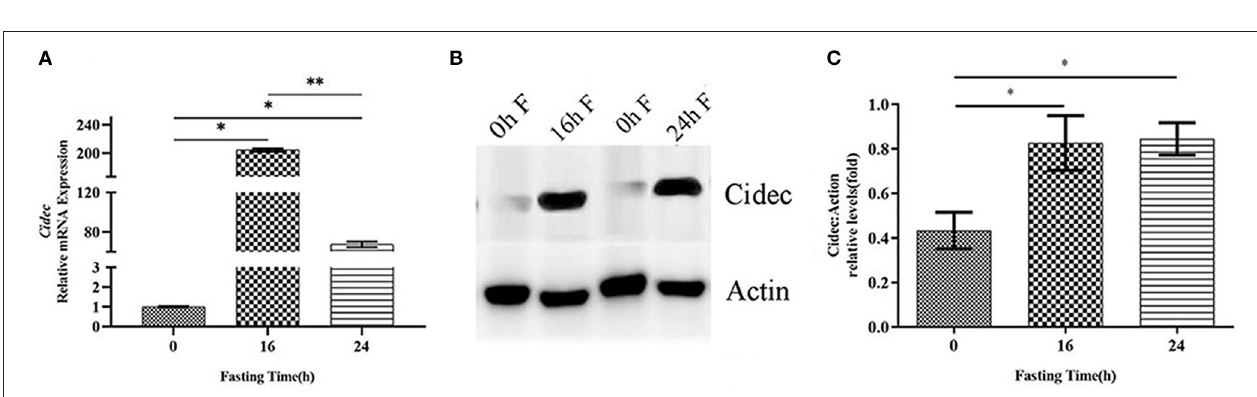
FIGURE 2 | Effects of fasting on the Cidec expression in HFD mice. (A) mRNA expression levels of Cidec in the liver of HFD mice subjected to 16h and 24h fasting. (B) Protein expression levels of Cidec in the liver of HFD mice subjected to 16h and 24h fasting. (C) Histogram plotted with the corresponding grayscale values in the (B) . Data in (A,C) were analyzed by t-test, with actin as the internal control. * P < 0.05, ** P <